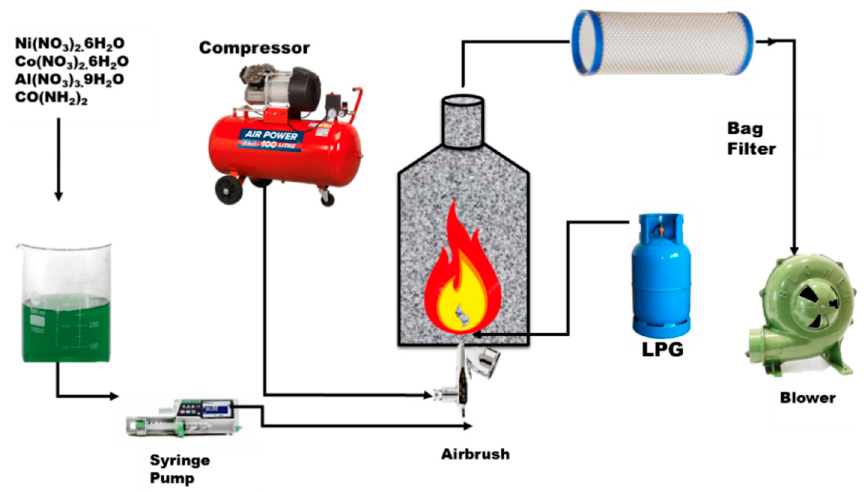
Figure 1. Schematic diagram of NCA production via flame assisted spray pyrolysis